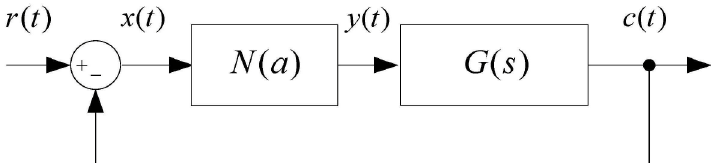
Figure 6. A simple nonlinear feedback system.